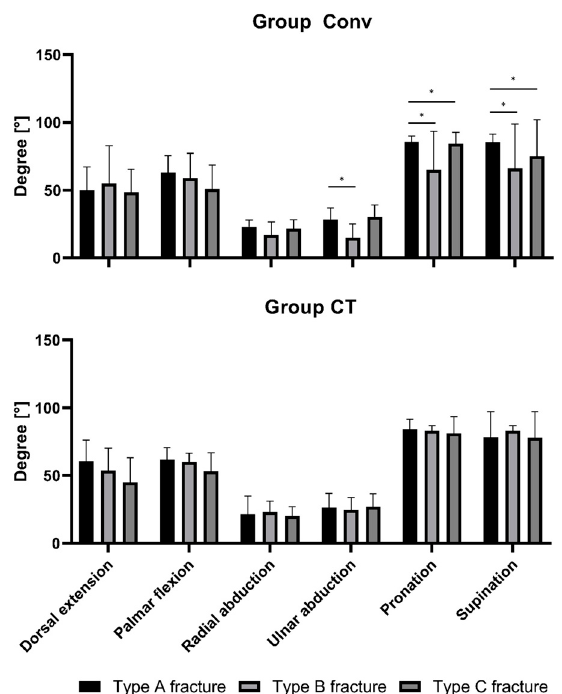
Figure 1. Comparison of Range of Motion (ROM) at six months after initial surgery of Group CT and Group Conv. While there is a significant difference amongst the subgroups in Group Conv, the ROM appears to be independent of the severity of fracture in Group CT. Types of fracture are classified according to the AO classification; * = significant difference ( p < 0.05).